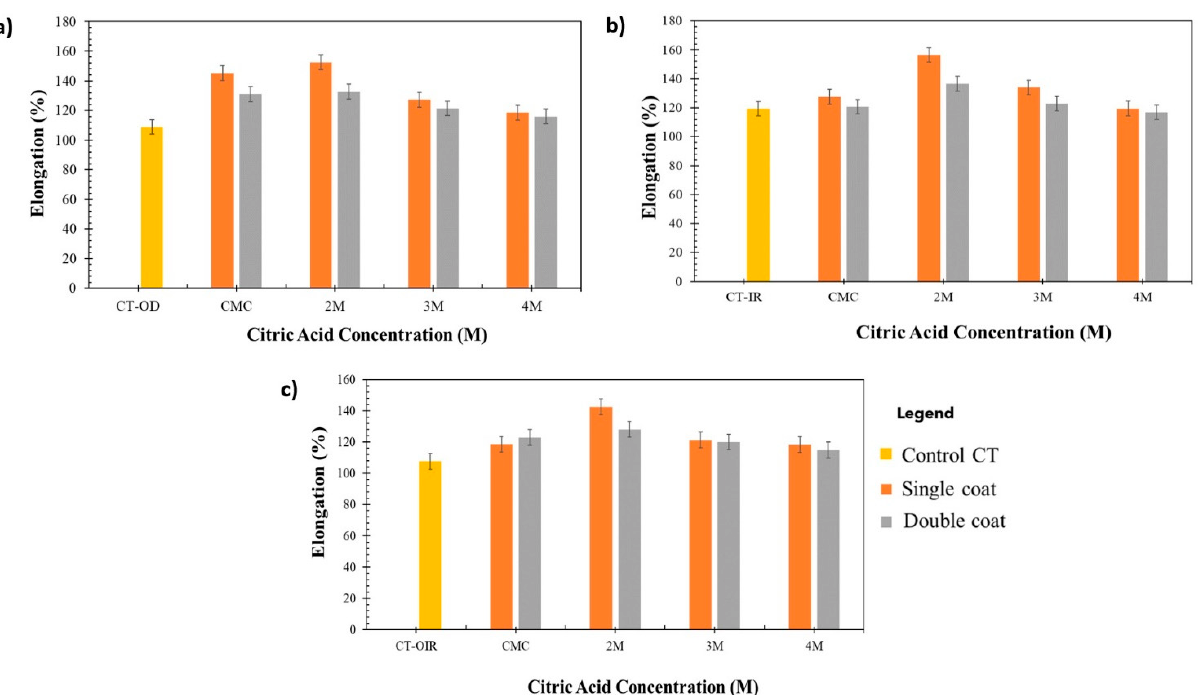
Figure 6. Tensile strength of CT/CMC cross-linked with different CA concentrations dried by ( a ) OD, ( b ) IR, and ( c ) OIR